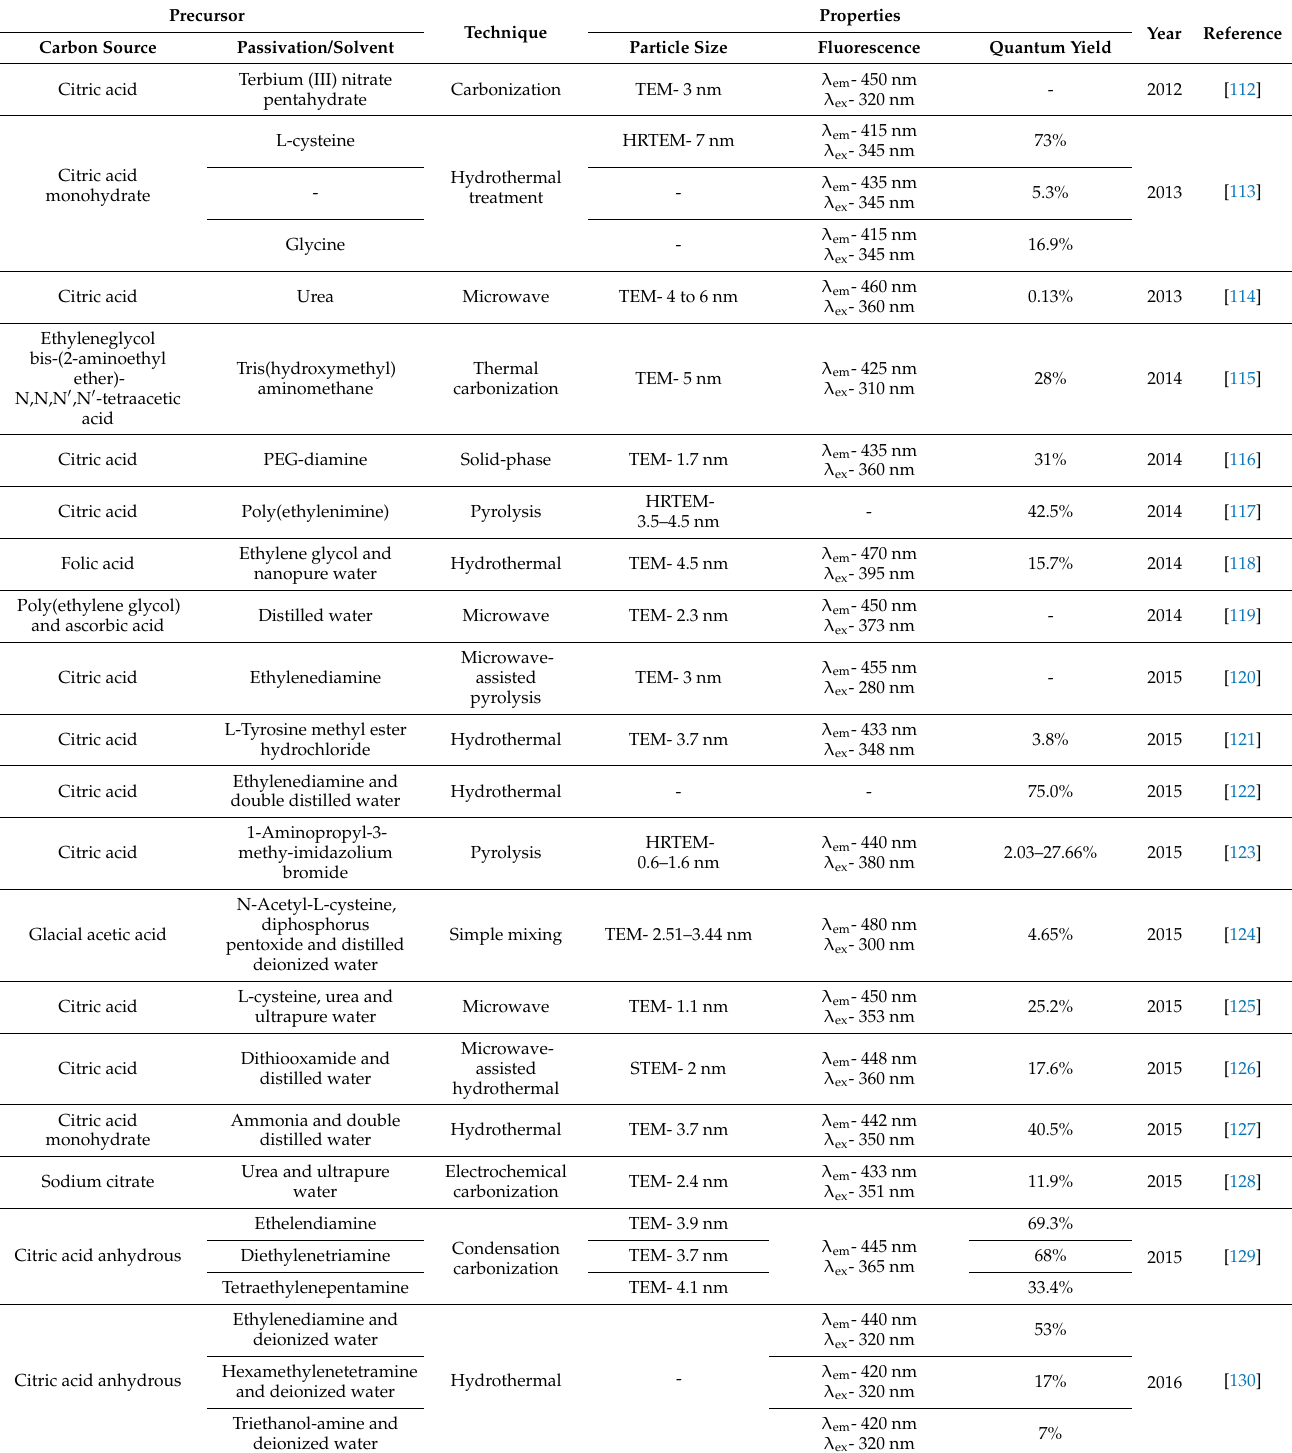
Table 8. Summary of the synthesis of CDs from acid